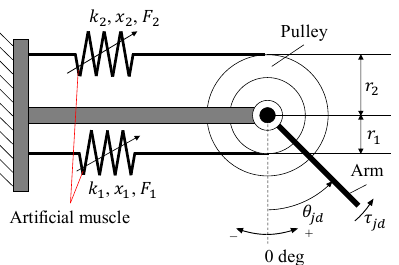
Figure 3. The model of the viscoelastic joint. This joint can obtain any joint angle and joint stiffness by controlling the air pressure applied to the artificial muscle. Table 1. Parameter of the viscoelastic joint.